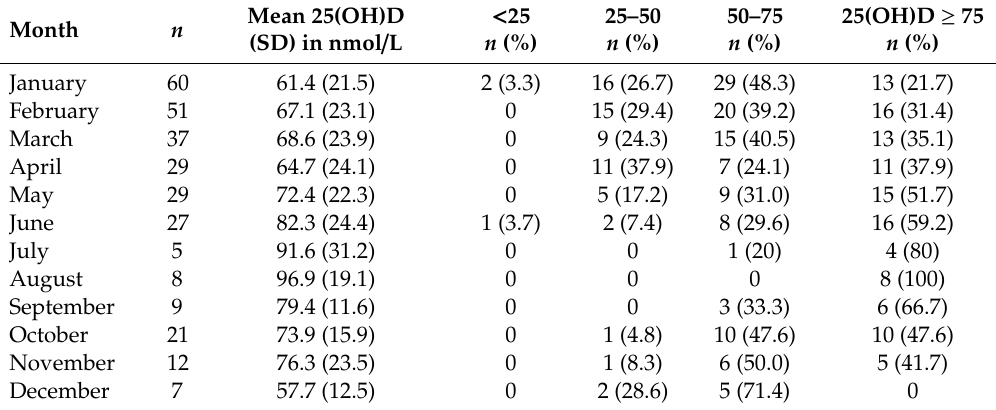
Table 2. Plasma 25(OH)D levels by month in a population of Norwegian